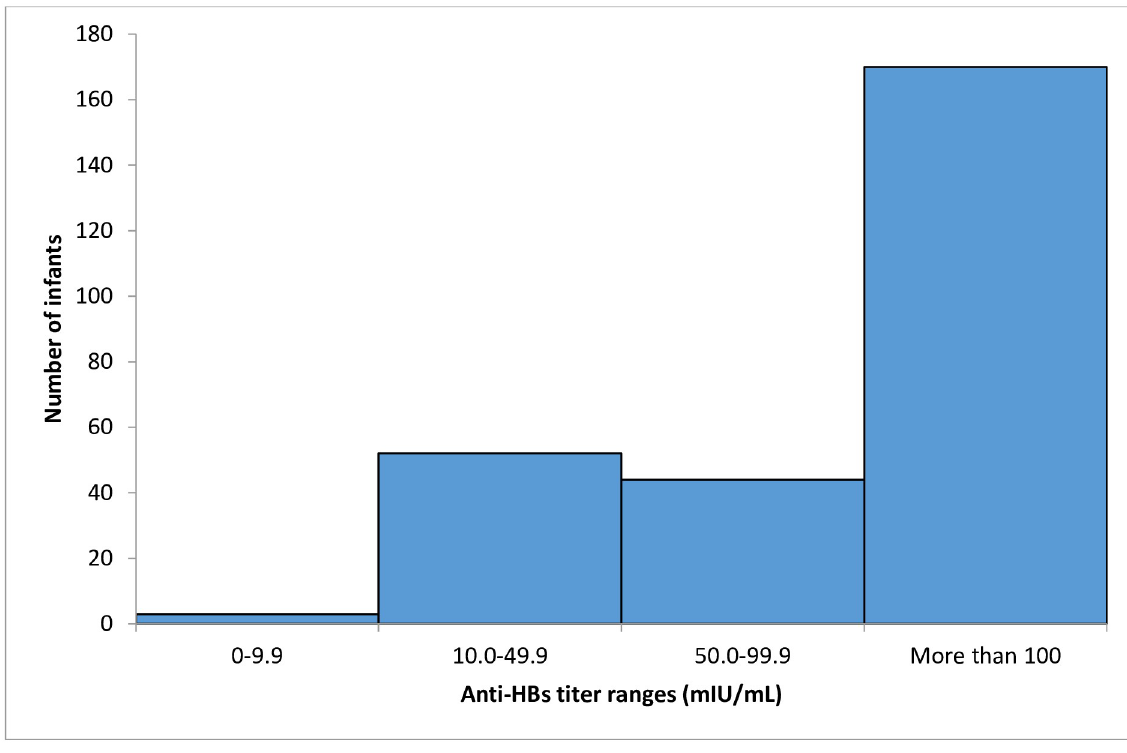
Fig 1. Anti HBs titer ranges for children plasma